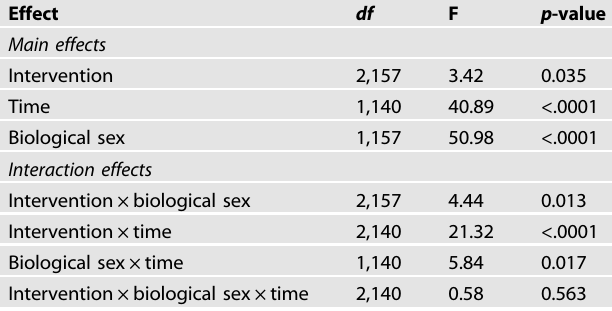
Table 3. AL ratio as a function of intervention group, biological sex, and time among older adults with obesity following a 12-month exercise and diet